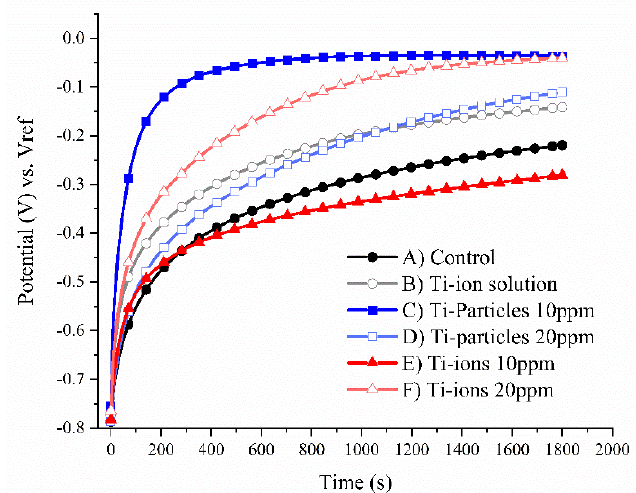
Figure 2. Representative open circuit potential (OCP) curves.